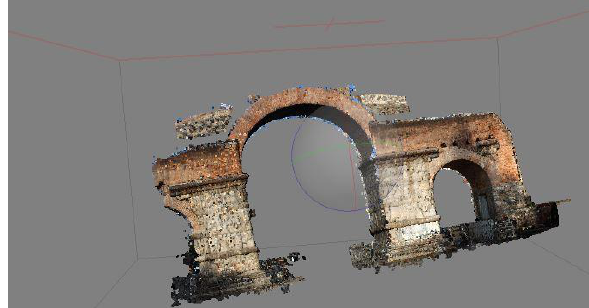
Figure 7. Dense point cloud (east